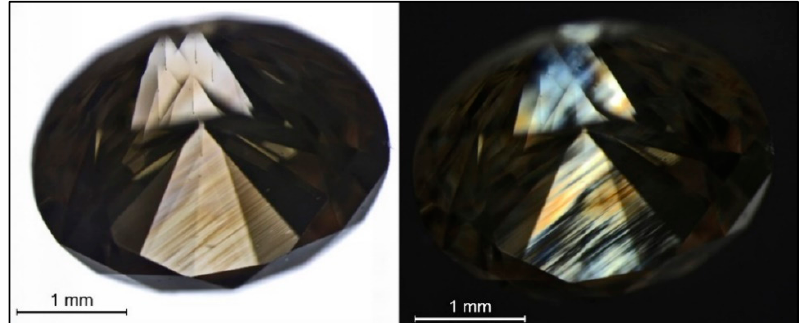
Figure 3. A brown hydrogen-rich type IaB diamond (sample TH 2.619) that clearly shows its color being caused by deformation-related brown color lamellae (left, immersion) along the octahedral crystal directions; the characteristic extinction patterns following the brown lamellae (“graining”) can be seen on the right (immersion, crossed polarizers).